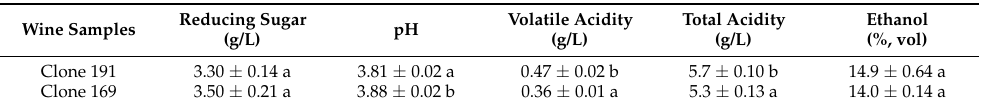
Table 1. Physicochemical parameters of wines made of Cabernet Sauvignon clone 169 and 191 before